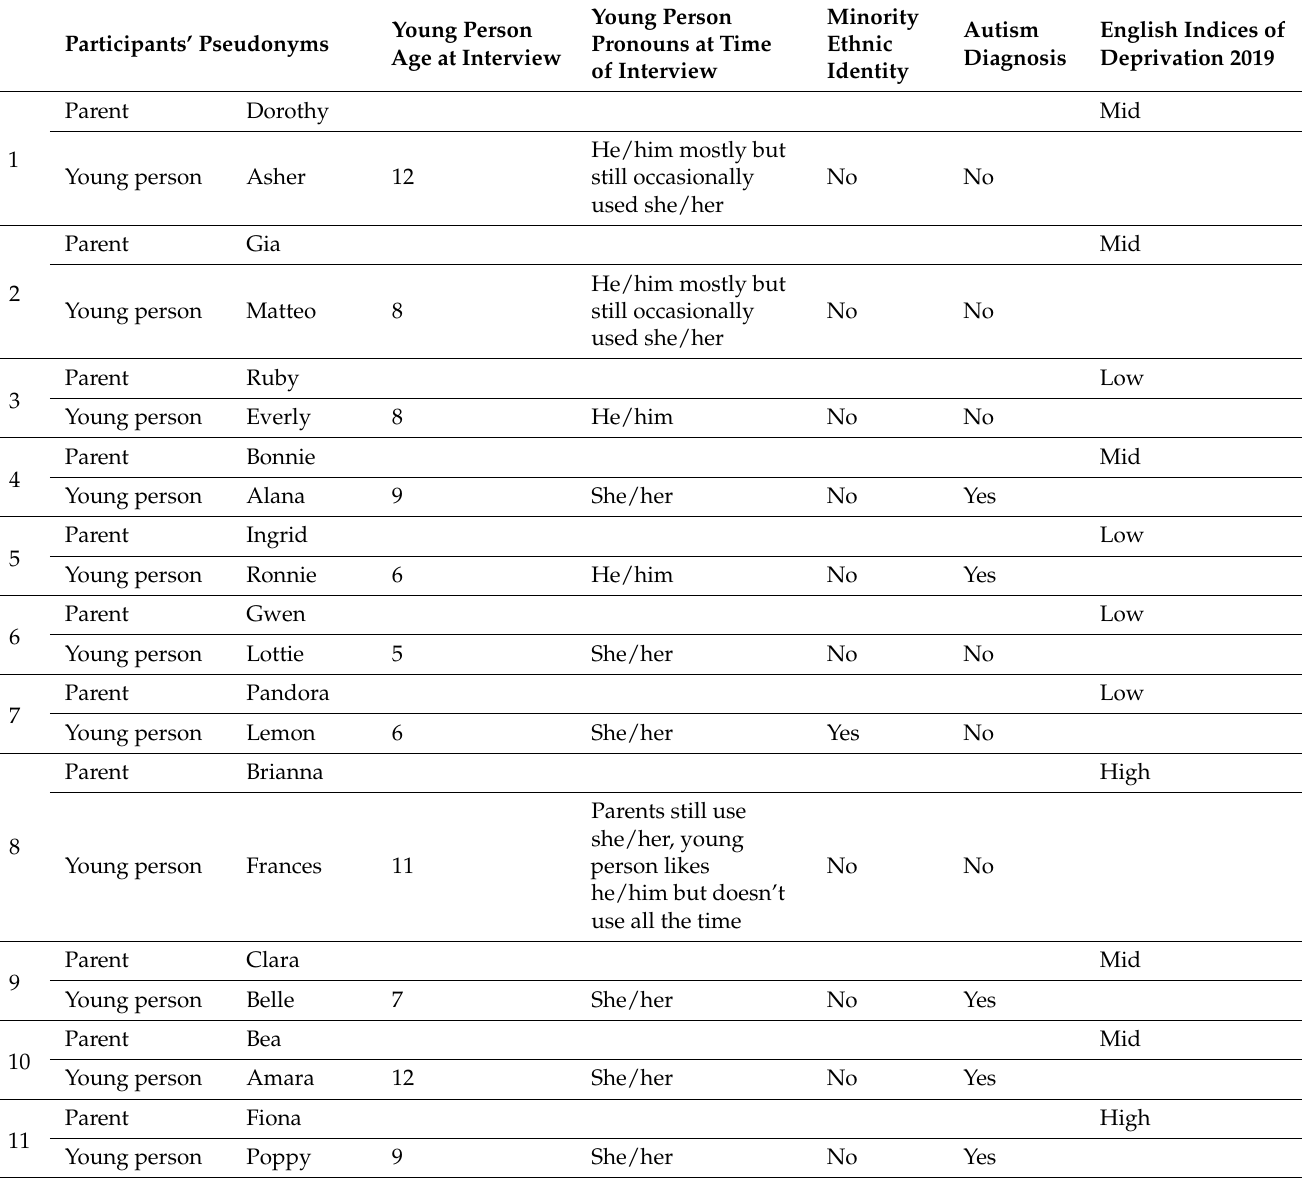
Table 1. Participant demographic